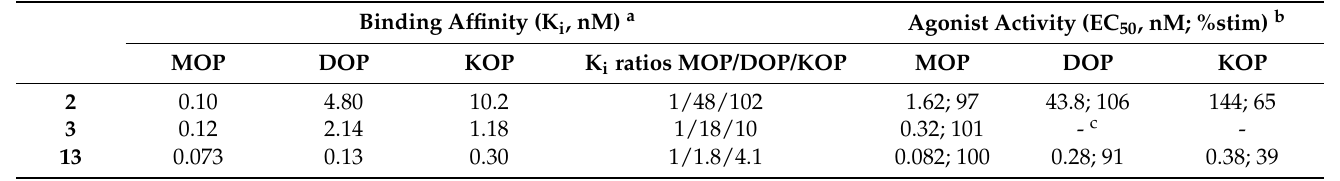
Table 4. Binding affinities and agonist potencies of N -methylmorphinan-6-ones 2 , 3 and 13